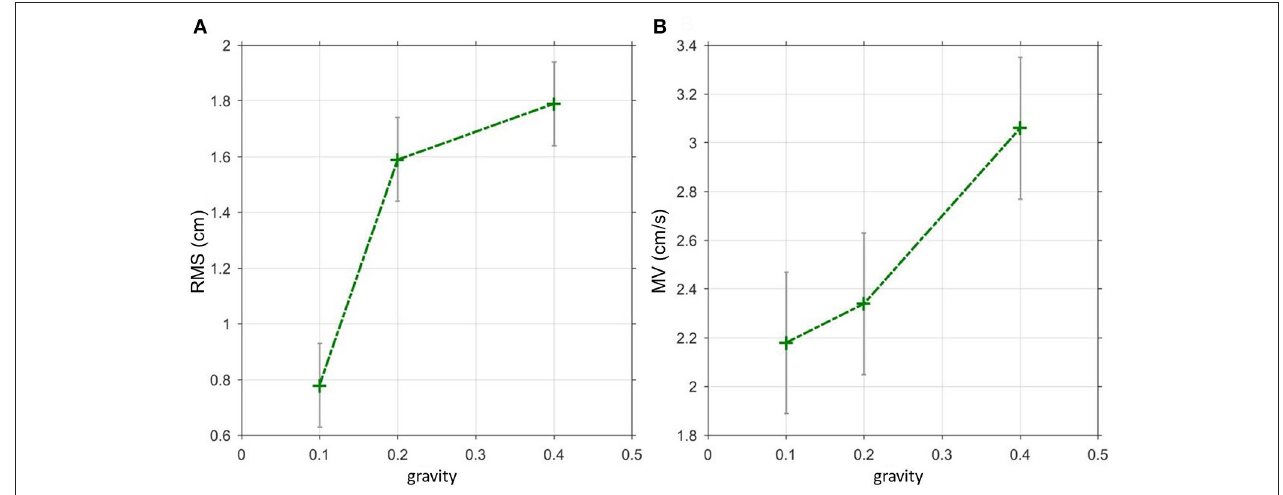
FIGURE 2 | Spontaneous sway during virtual balancing. (A) Root Mean Square (RMS) and (B) Mean Velocity (MV) as a function of the amount of virtual gravity.